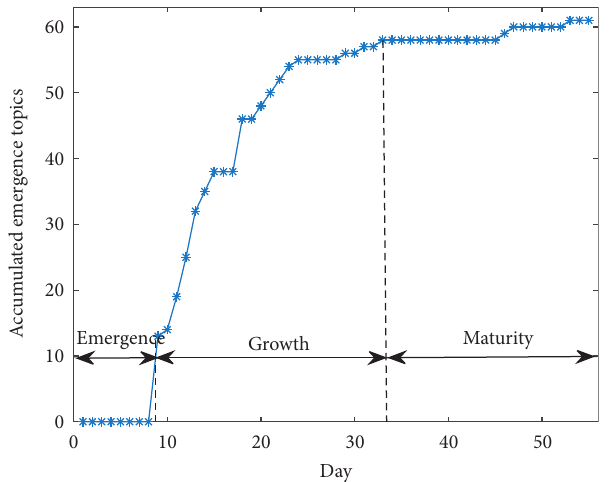
Figure 2: The topic lifecycle of Huawei P10/P10